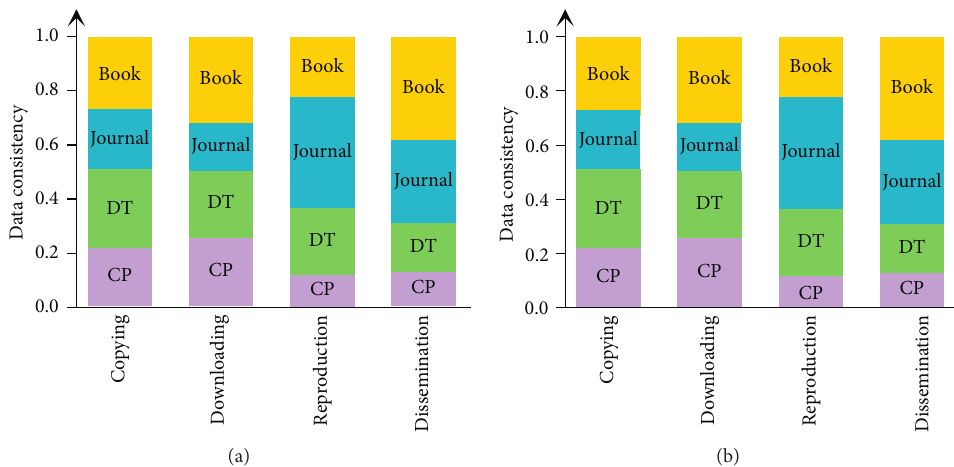
Figure 3: Educational resource data consistency of the main four intellectual properties in the processes of copying, downloading, re- production, and dissemination. DT: dissertations; CP: conference papers. (a) Data classification and (b) protection authority